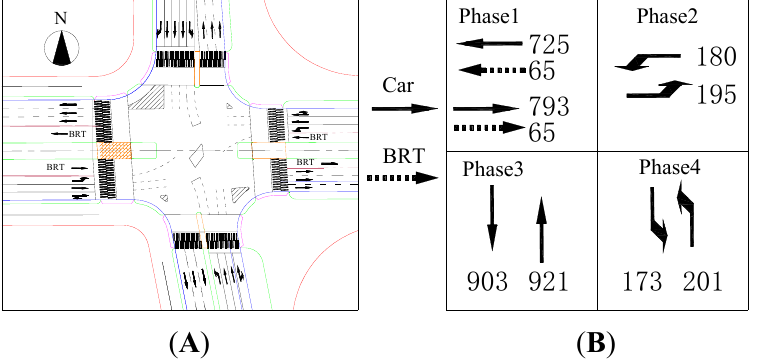
Figure 3. Basic parameters of the intersection used in the case study. ( A ) Layout of the intersection; ( B ) Phase sequence and traffic